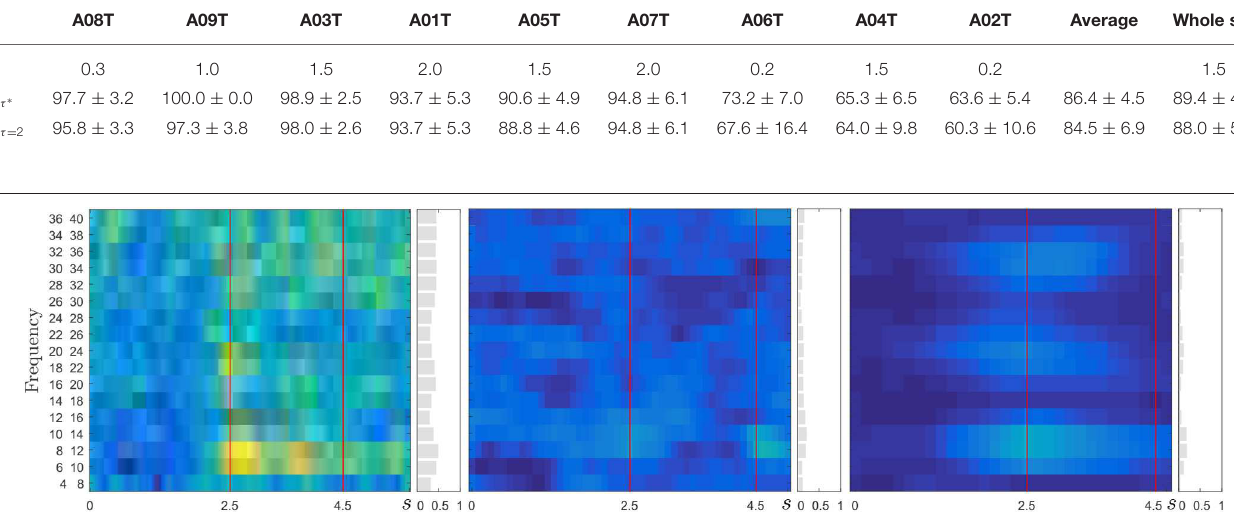
FIGURE 2 | Estimation of J using the optimal time window τ . (Left) the subject A08 (achieving the best accuracy), (Center) the patient A02 (worst accuracy), and (Right) the group analysis performed at the admitted value τ = 2 s for validating the tested MI Dataset 2a. Spectral relevance is colored in gray